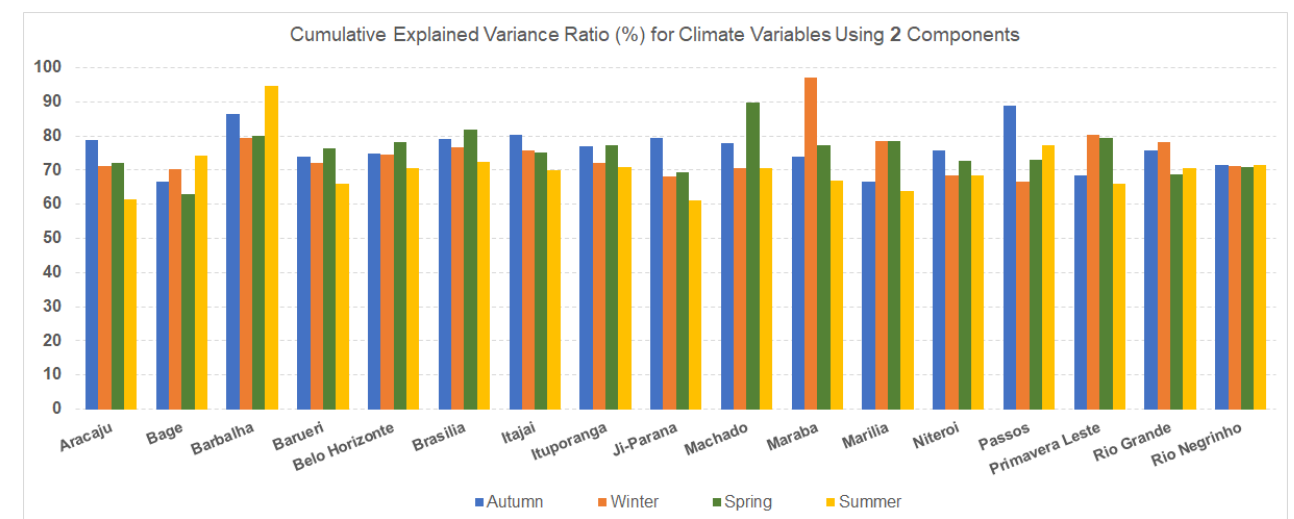
Figure 10. Overview of the percentage of representation of the variance of climate variables considering two principal components. Source: own authors.